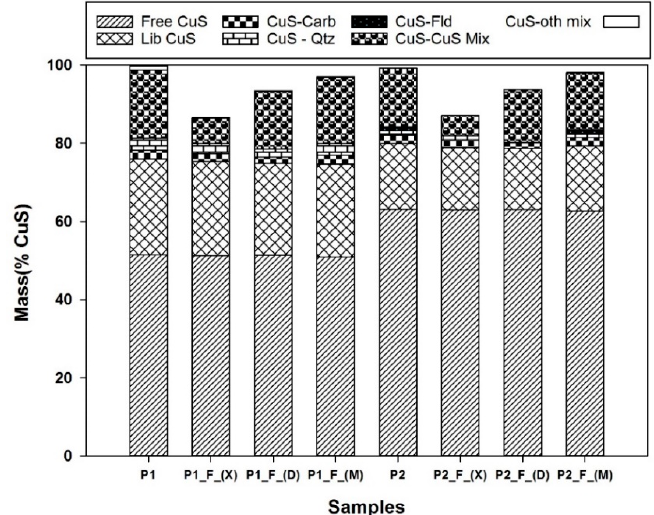
Figure 2. A photomicrograph of the copper sulphides present in the ore. Cc—chalcocite; Bn—bornite; Cp—chalcopyrite; and Cv—covellite.